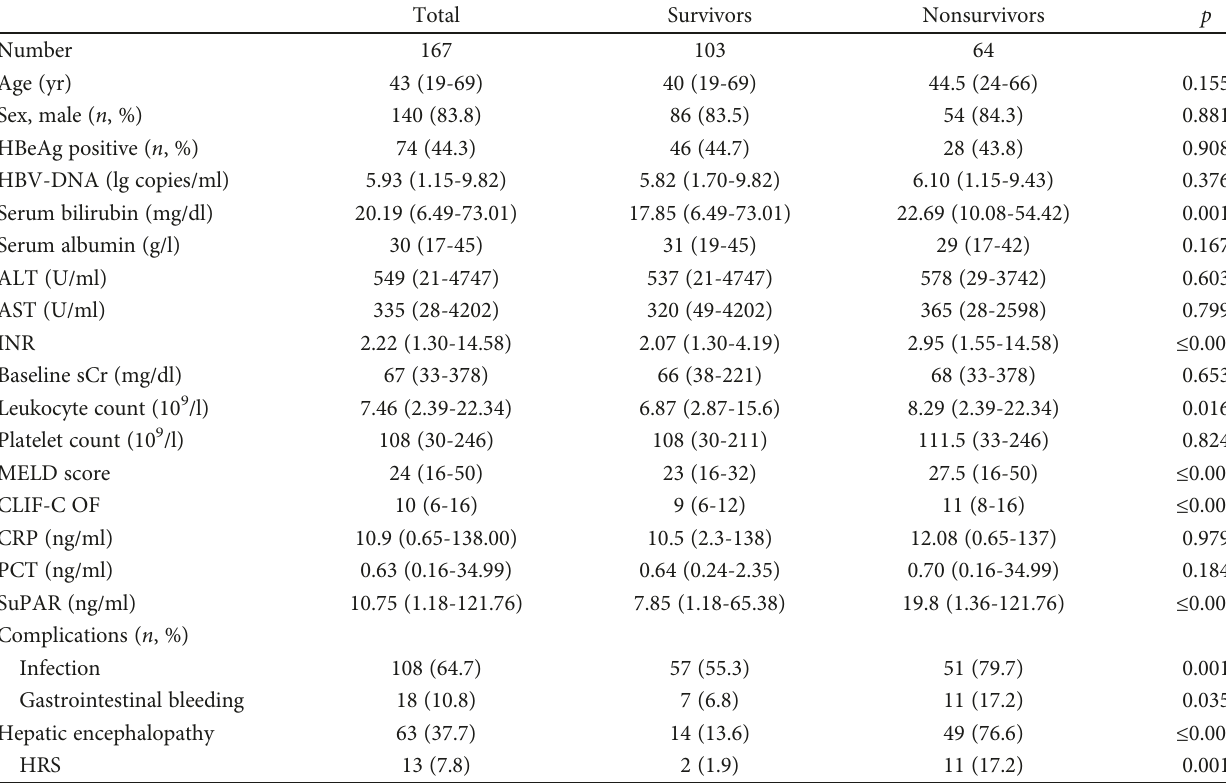
Table 2: Baseline demographic, clinical, and laboratory characteristics of HB-ACLF survivors and nonsurvivors in the validated set.